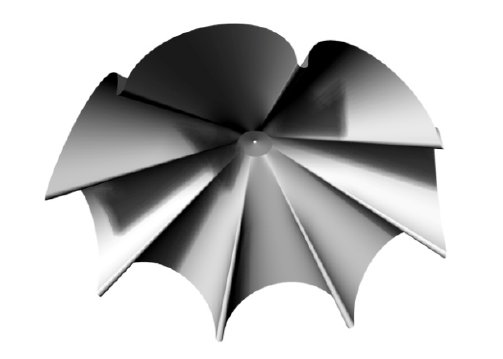
Figure 9. View of the ideal